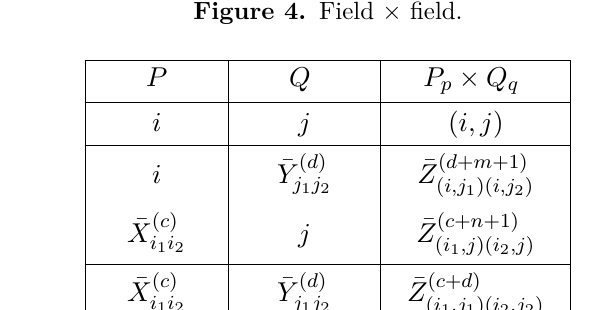
Figure 4. Field × field.